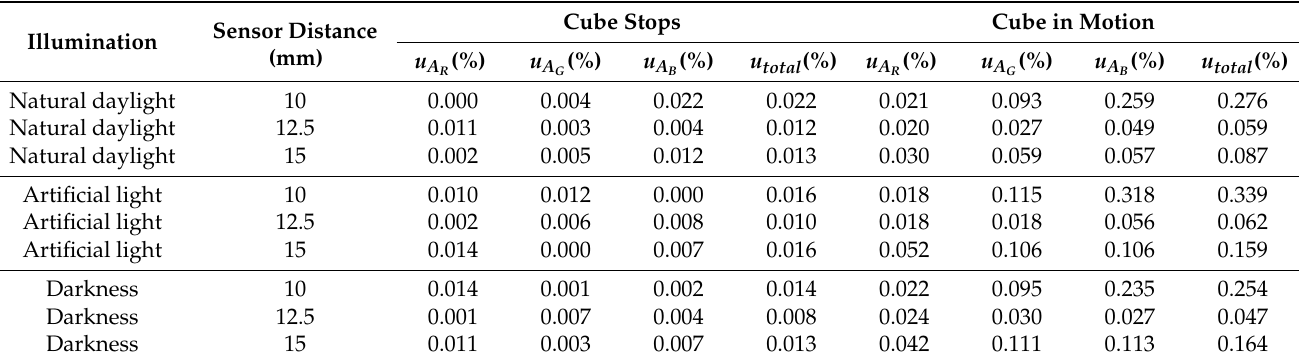
Table 5. Type A standard uncertainty for a blue